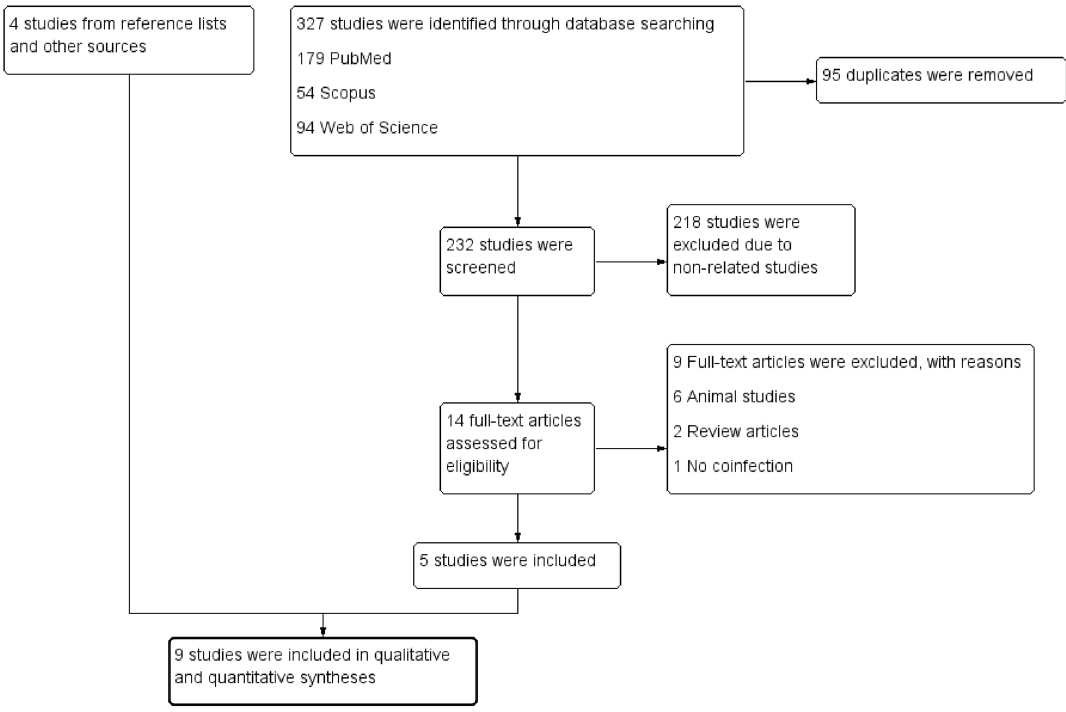
Figure 1. Study flow diagram demonstrated the selection of relevant